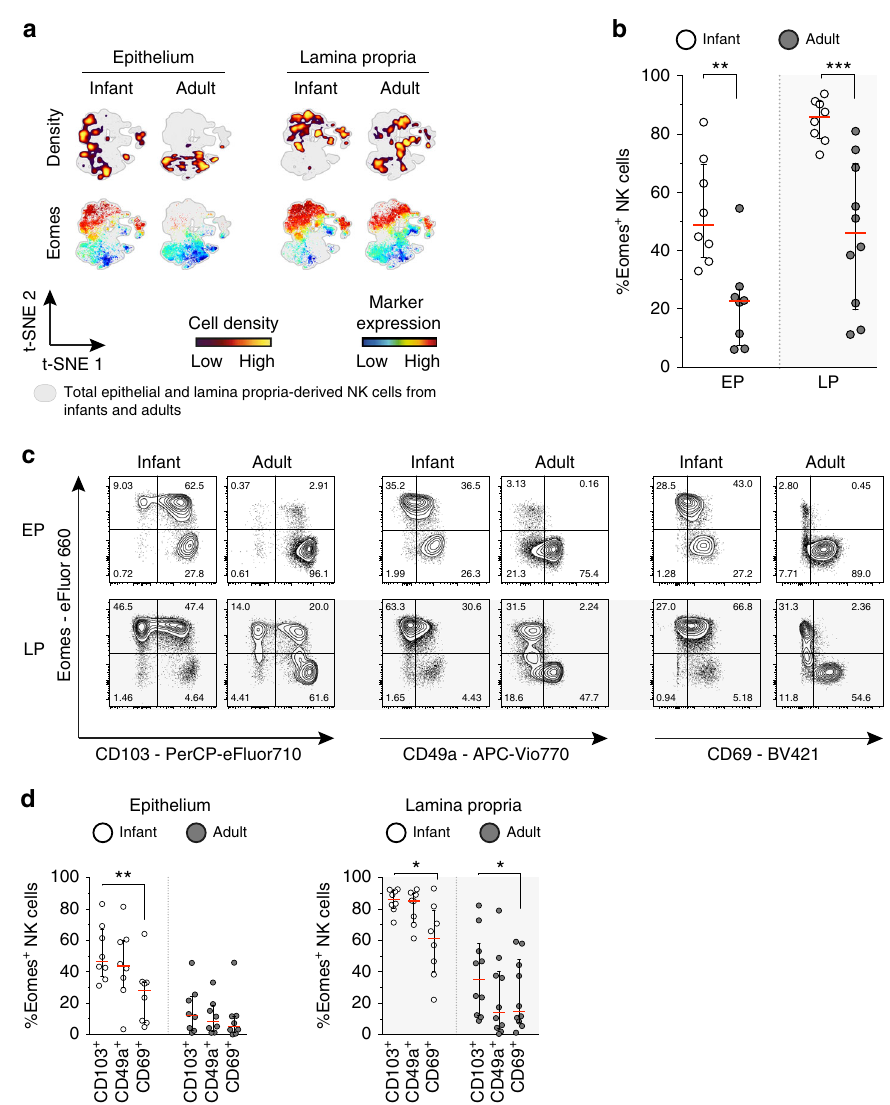
Fig. 5 High expression of Eomes in infant intestinal NK cells. a viSNE plots of combined fl ow cytometric data visualizing Eomes expression of infant and adult NK cells from epithelium (EP) and lamina propria (LP) intestinal tissues. Cell density of clusters is shown in fi rst row. Expression of Eomes is shown by color coding in relative intensity in second row. viSNE plots have been calculated from concatenated FCS fi les gated on NK cells (infant samples N = 7, adult samples N = 5, iterations = 7500 perplexity = 100, KL divergence = 2.62). b Frequencies of EP and LP-derived infant (white circles) and adult (dark circles) Eomes + NK cells. c Representative fl ow cytometric plots showing co-expression of Eomes and tissue-residency markers (CD103, CD49a, CD69) in NK cells from EP and LP of infant and adult intestines. d Frequencies of Eomes + NK cells within CD103 + , CD49a + , or CD69 + NK cell populations in EP and LP of infants (white circles) and adults (dark circles) (infant samples N = 8 (EP and LP), adult samples N = 8 (EP), and N = 10 (LP)). Median frequencies indicated by red lines. Error bars de fi ne interquartile ranges between 75th and 25th percentiles. Statistical comparisons are Mann-Whitney U comparisons ( b ) and Wilcoxon matched-pairs signed rank tests ( d ). Asterisks represent the following p -values: * p < 0.05; ** p < 0.01; and *** p <